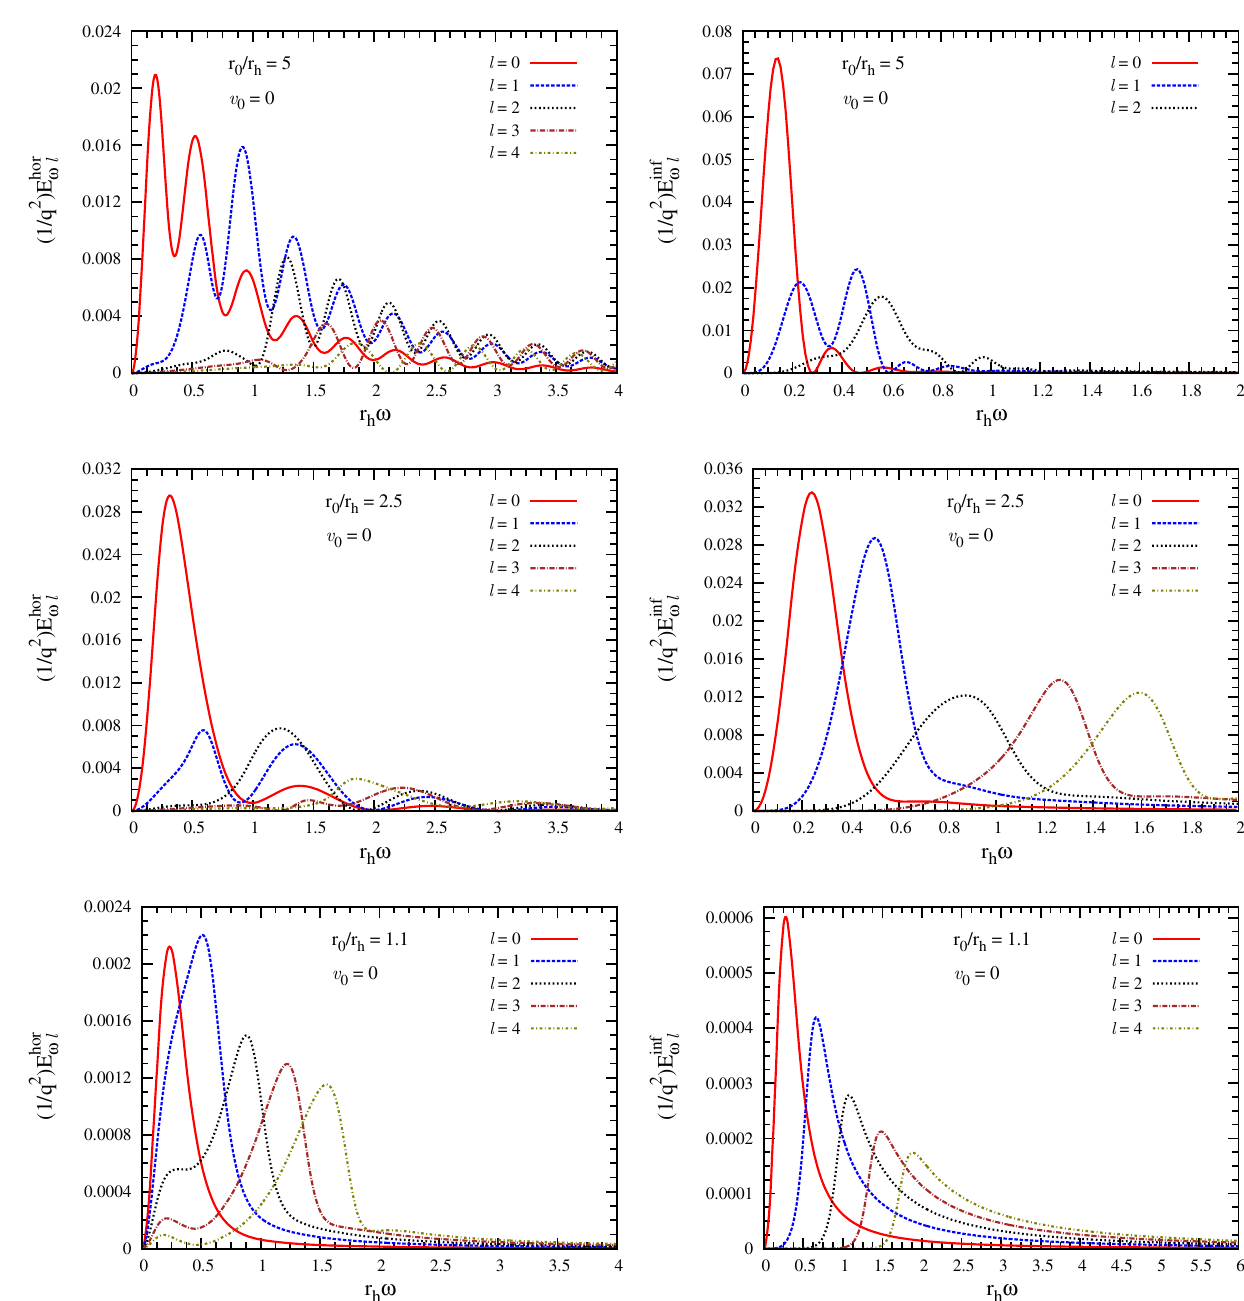
Fig. 4 Numerical estimates of the spectra of the emitted energy, E hor ω and (38), considering a source infalling from rest ( v 0 = 0) at posi- l tions r 0 = 5 r h (plots at the top), r 0 = 2 . 5 r h (plots in the middle) and (plots on the left) and E inf ω (plots on the right) as a function of ω l r 0 = 1 . 1 r h (plots at the bottom) for selected values of the multipole number, obtained from Eqs. (34) The results for the emitted energy spectra E hor ω and E inf ω l l for the radial infall of a source starting from rest for selected values of position r 0 obtained numerically from Eqs.